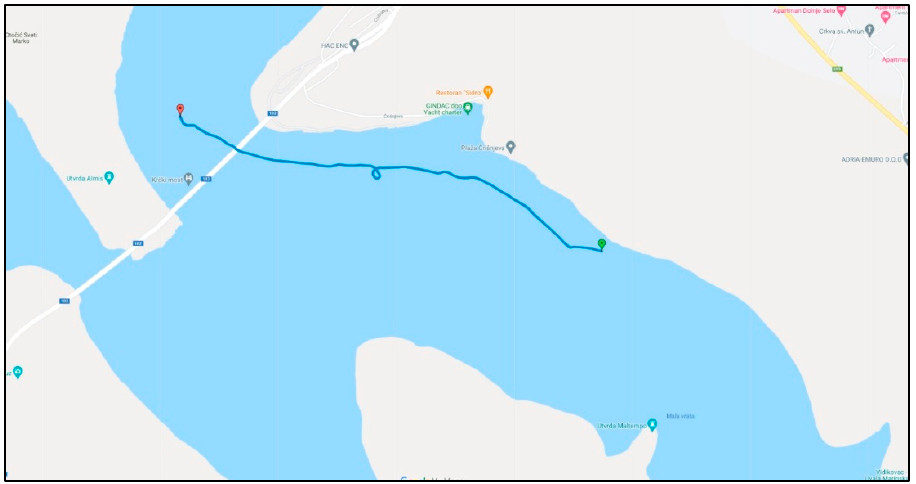
Figure 6. Sample of the route of the marine drone (1 NM).